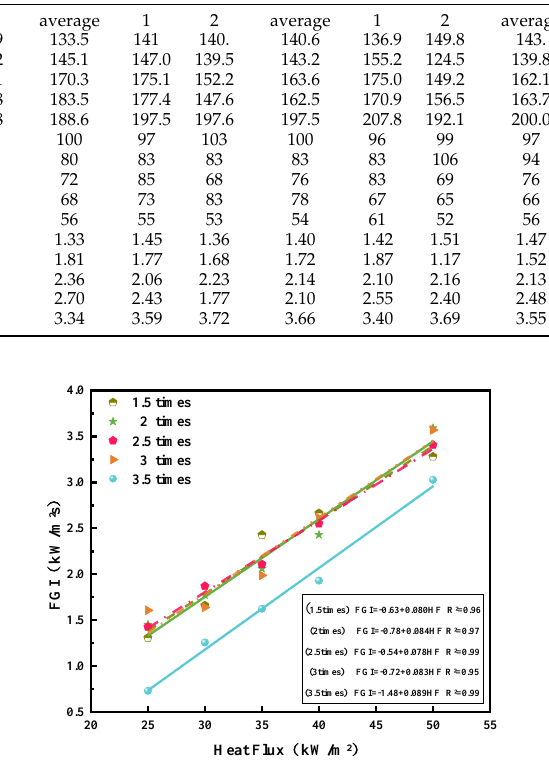
Figure 9. FGI for the wires at various external heat fluxes.